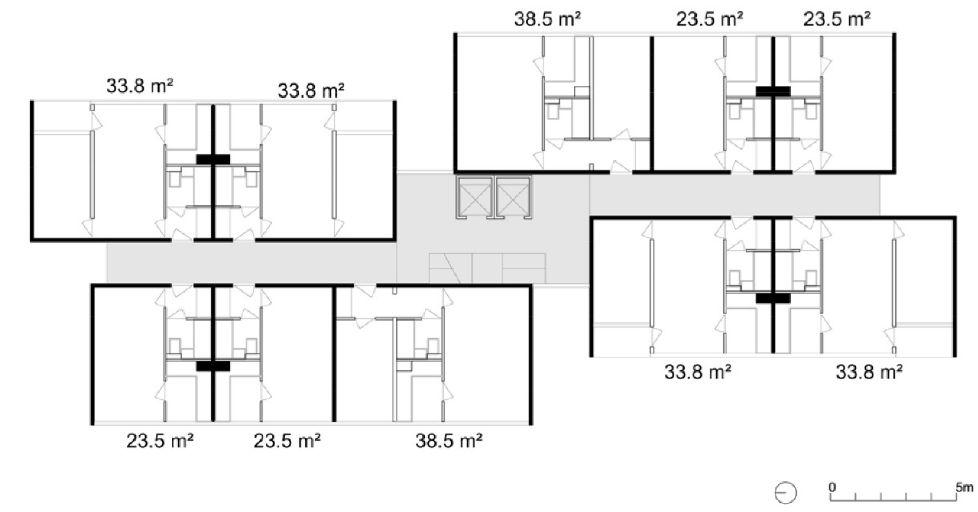
Figure 6. Plan of the exemplary building in the Polish WWP large-panel system with information about the useable area of each apartment. Drawing by the author based on [28].